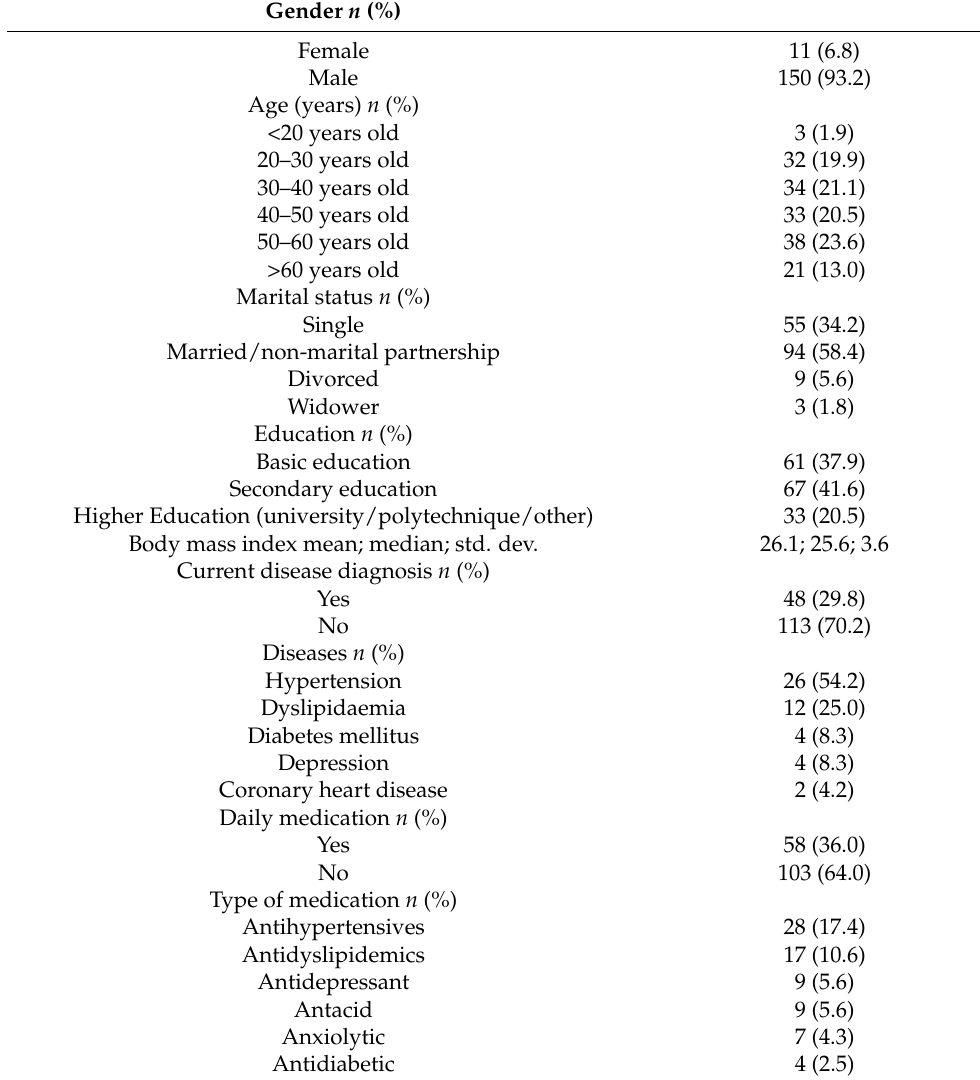
Table 1. Sociodemographic and clinical characterisation of the